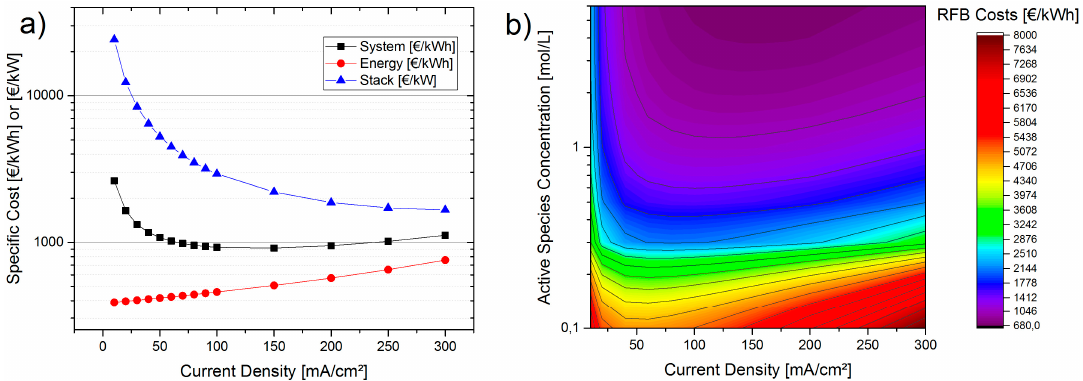
Figure 5. Costs of a 10 kW/120 kWh VRFB system, showing ( a ) variation in current density and ( b ) variation in current density and in the concentration of vanadium.